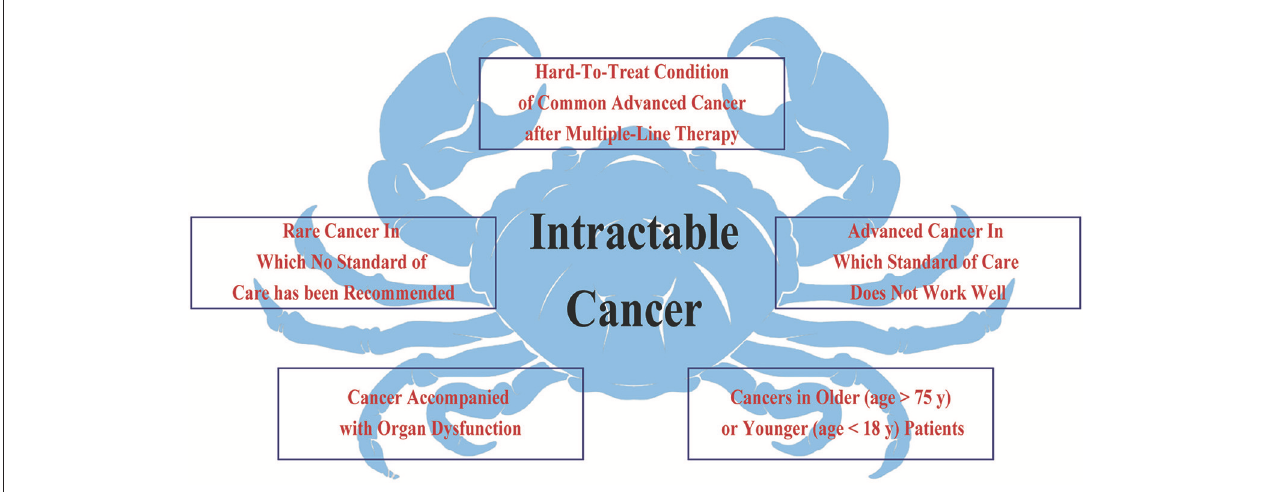
FIGURE 1 | Intractable cancer refers to a type of cancer or condition of cancer that does not respond to/is resistant to cancer treatment. The common characteristics include, no standard treatment for that cancer type and status, standard treatment that has not worked well, and lack of highly effective and low-toxicity regimens. Therefore, intractable cancer could be divided into five